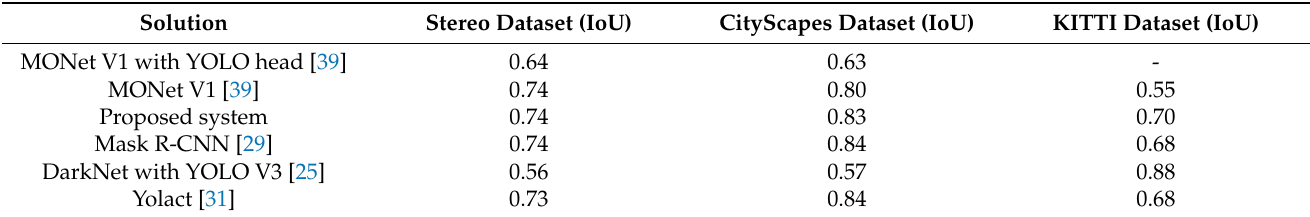
Table 1. Bounding box